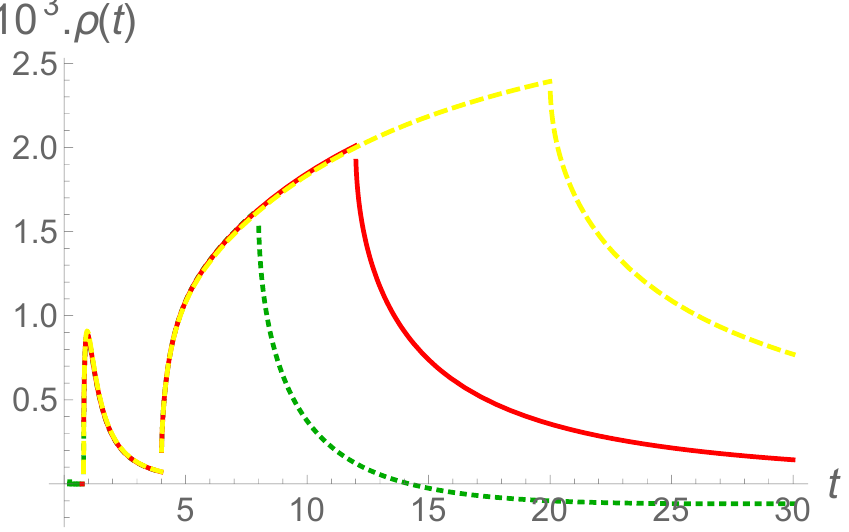
Figure 10 . Spectral function for the reduced Higgs propagator h h ( p ) h ( (cid:0) p ) i , for gauge parameters (cid:24) = 2 (Green, dotted), (cid:24) = 3 (Yellow, dashed), (cid:24) = 5 (Red, Solid), with all quantities given in units of appropriate powers of the energy scale (cid:22) , for the parameter values e = 1, v = 1 (cid:22) , (cid:21) = 1